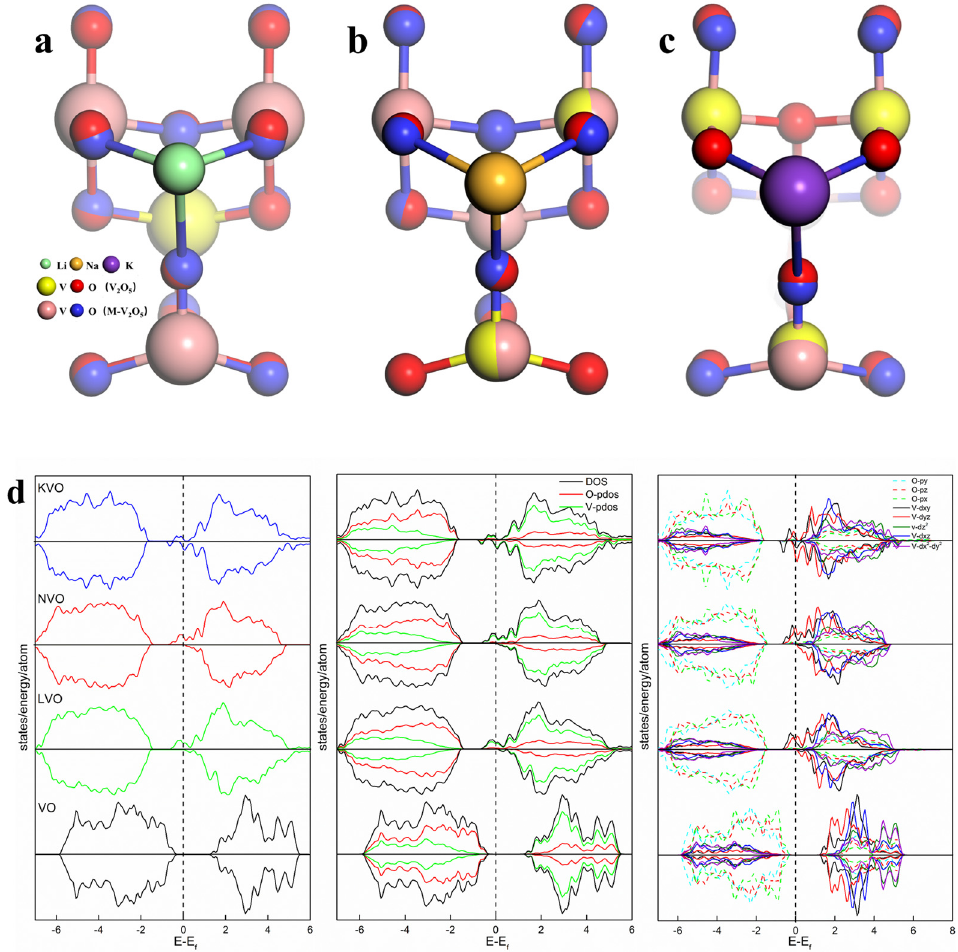
Figure 5. DFT predicted structure rearrangement after the pre-intercalation of Li ( a ), Na ( b ), and K Figure 5 . DFT predicted structure rearrangement after the pre-intercalation of Li (a), Na (b), and K 288 ( c ). ( d ) The orbital-projected density of state (PDOS) of Li-V-O, Na-V-O and (c). 289